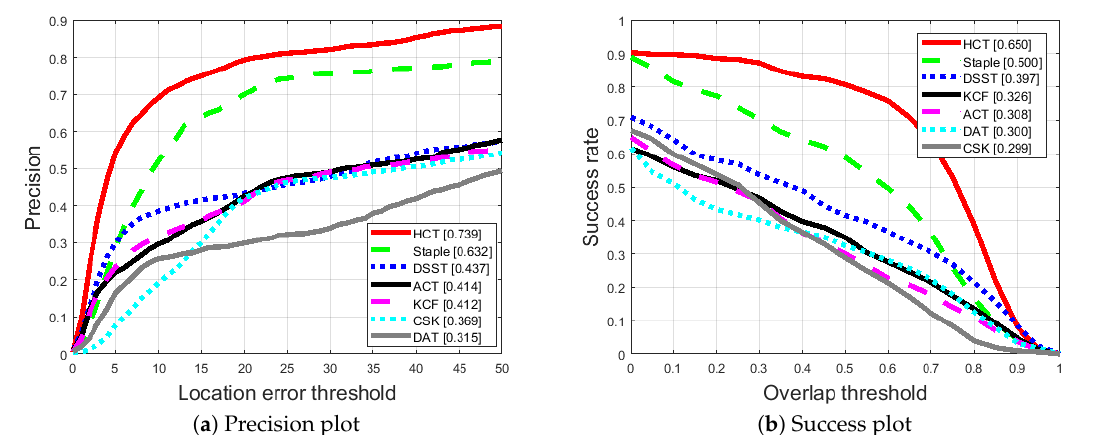
Figure 6. Quantitative comparison of the proposed HCT with several state-of-the-art